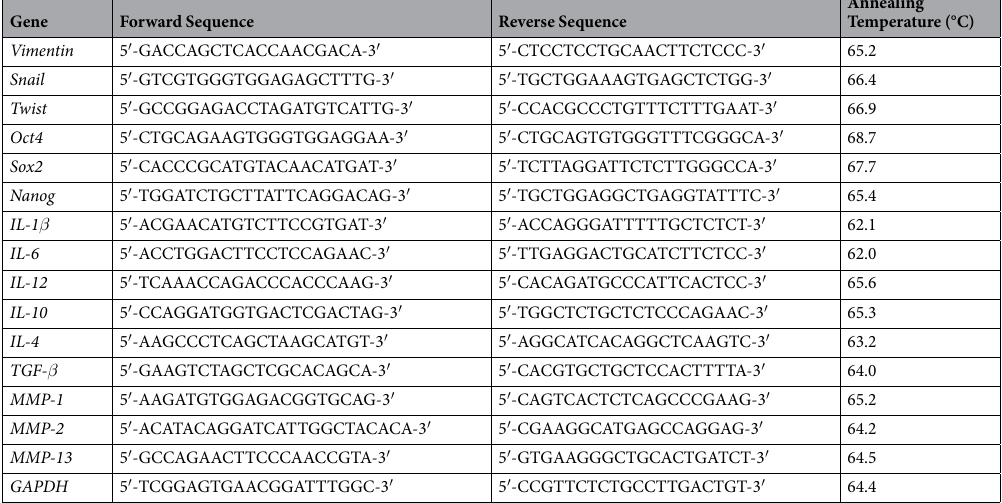
Table 1. Sequences of primers and conditions used in real-time